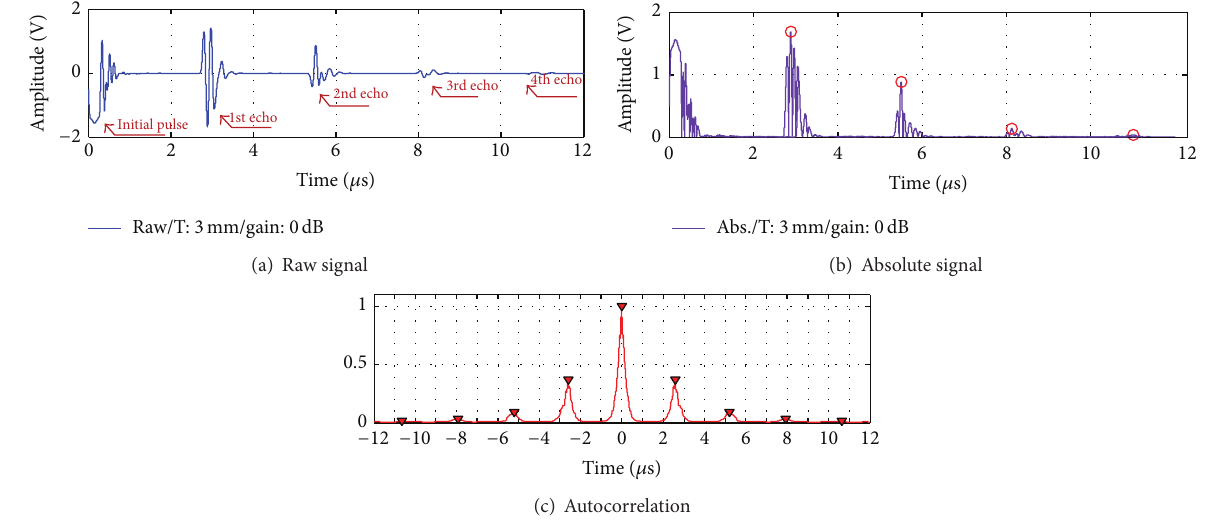
Figure 5: Signals of PVC sheets (T: 3mm/gain: 0 dB): (a) raw, (b) absolute, and (c) autocorrelation.